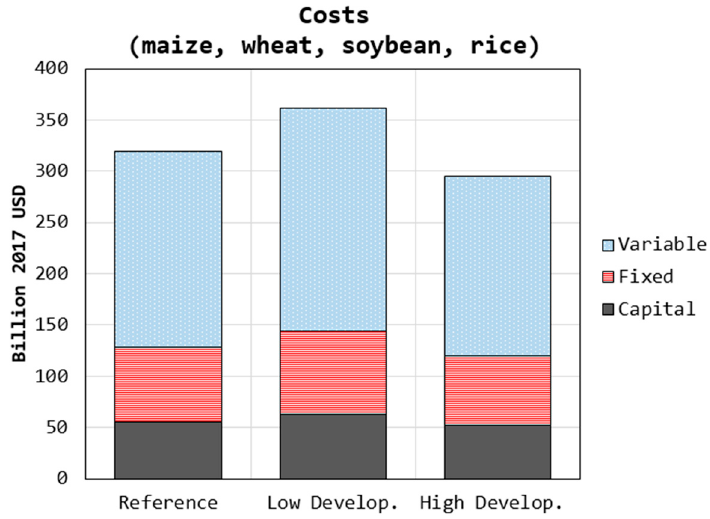
Figure 11. Necessary investment for each analysed scenario.